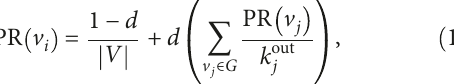
Figure 1: changes in correlation of node overlapping, for the 10 analysed ranking methods, as the spreader size p is increased from 1% to 10% of the total network size N . Each synthetic network has N = 10,000 nodes. Figure 2: spatial dis- tribution of selected spreader nodes on the mesh network with N = 10,000 nodes. The top p = 1% nodes are